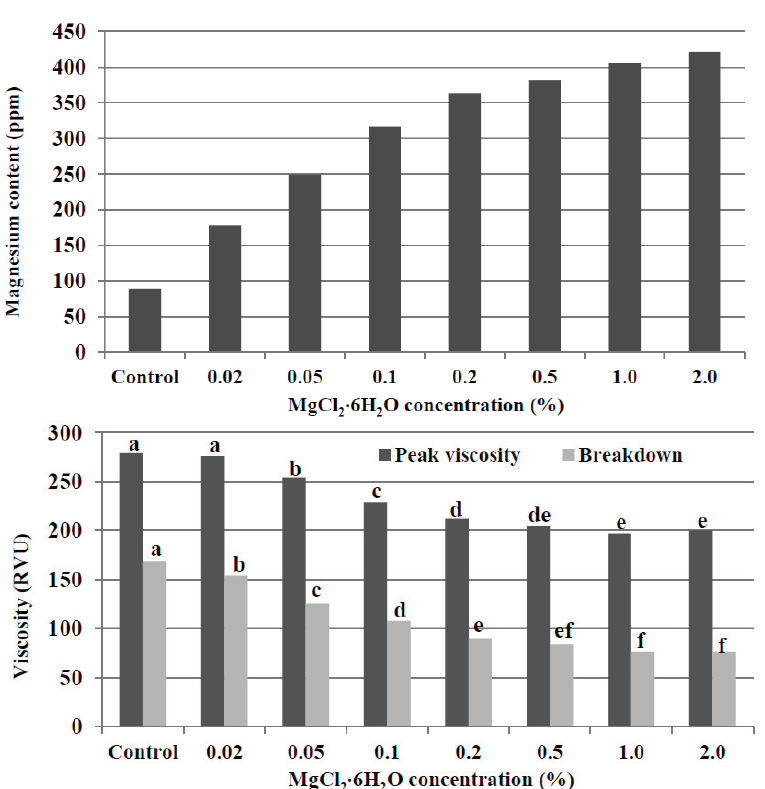
Figure 3. The magnesium content and RVA pasting properties of the potato starches treated with MgCl 2 aqueous solution. For each RVA parameter (peak viscosity or breakdown), bars labeled with the same letter are not significantly different ( p <